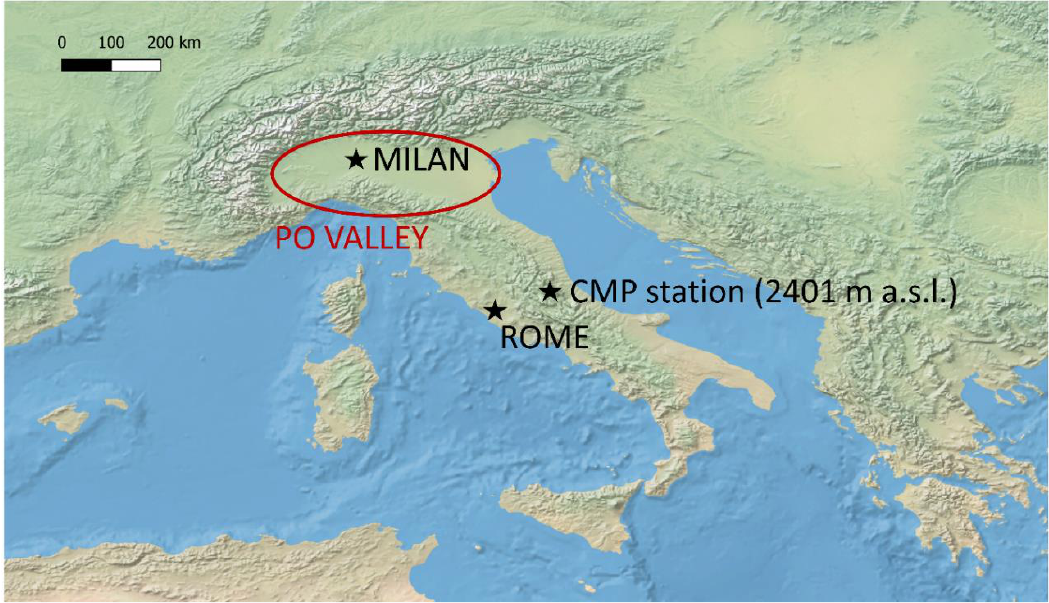
Figure 1. The location of the Mt. Portella (CMP) station in Central Italy. The raster map is from the Natural Earth website archive (available at http://www.naturalearthdata.com/).